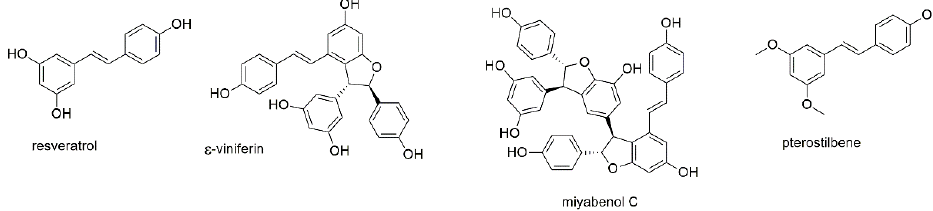
Figure 6. Stilbenoids with reported activity against myeloma cell